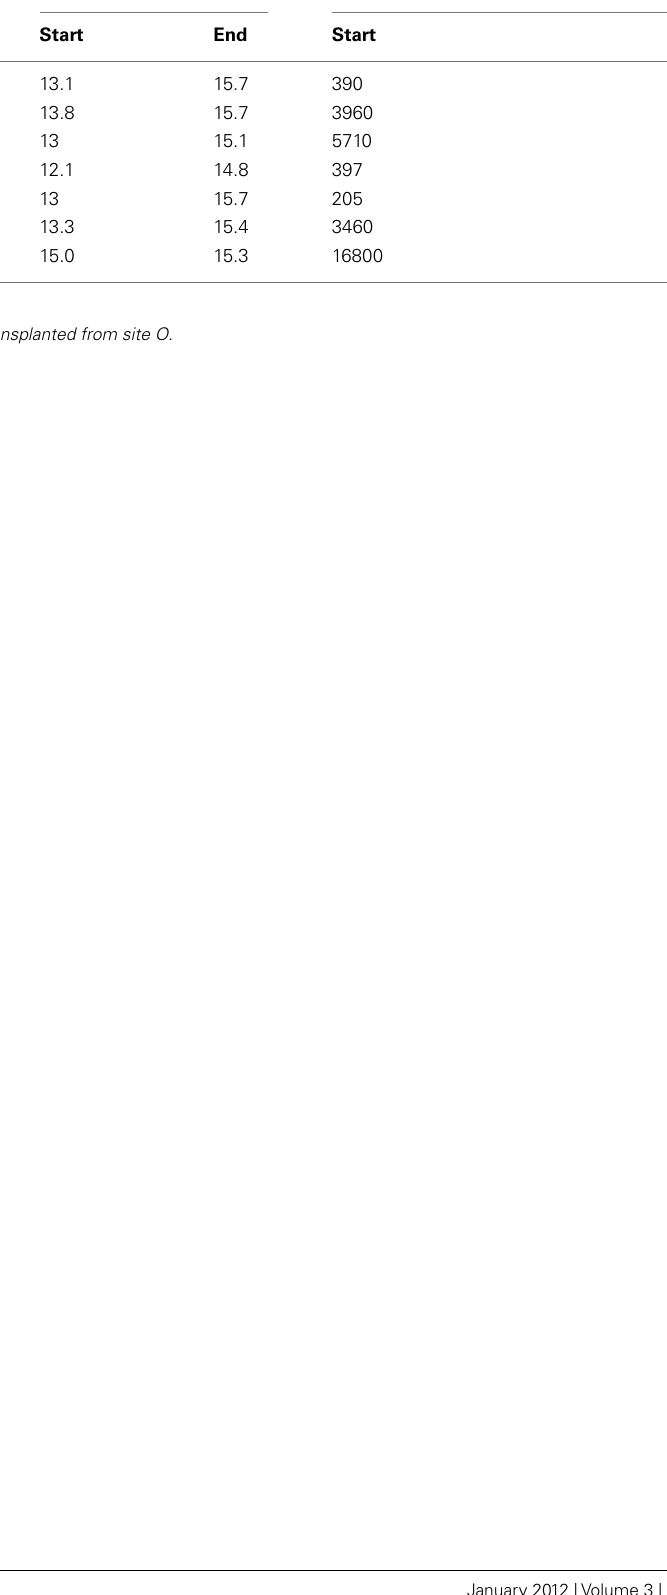
TableA1 | Ecological variables of Lakkasuo sites in the beginning (0day) and the end (28days) of the transplantation experiment. Site